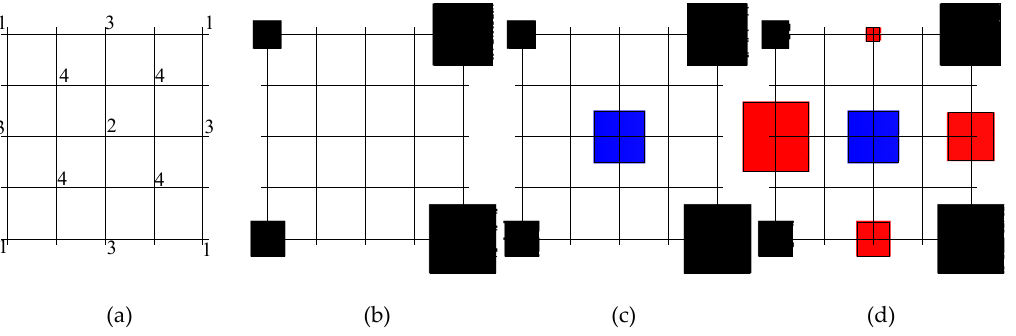
Figure 1. Elementary steps of the generation of single-cell fractal porous material: ( a ) initial grid; ( b ) corner point generated; ( c ) center value generated; ( d ) midpoint of each side generated.